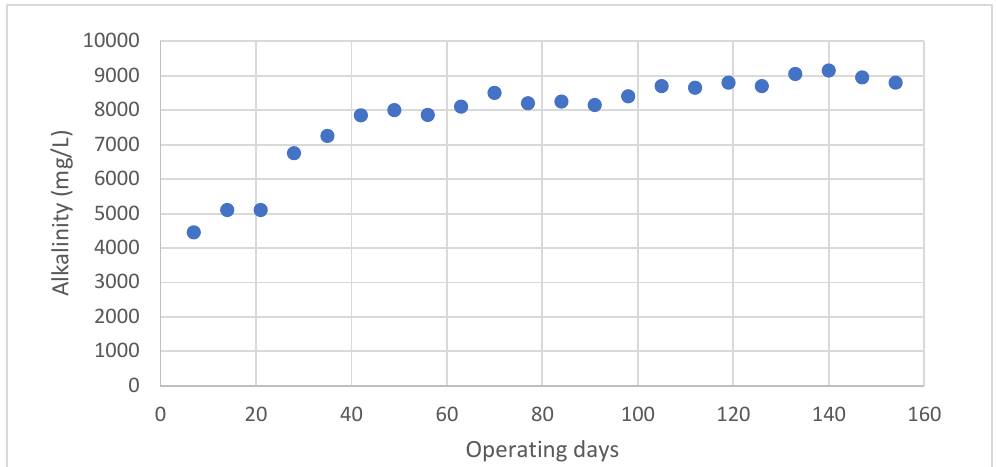
Figure 9. Change in alkalinity across operating days.